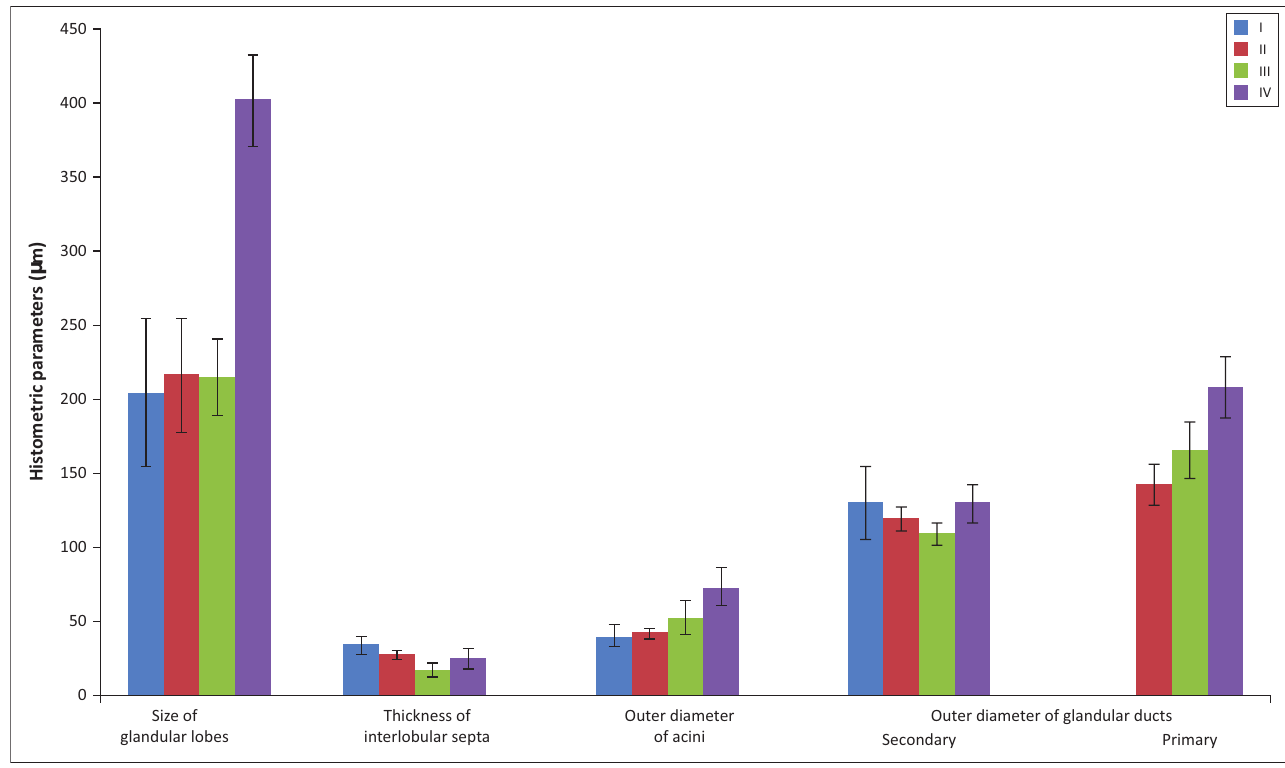
FIGURE 1: Morphometric parameters of the lacrimal gland in African black ostrich in the embryonic and postnatal period.